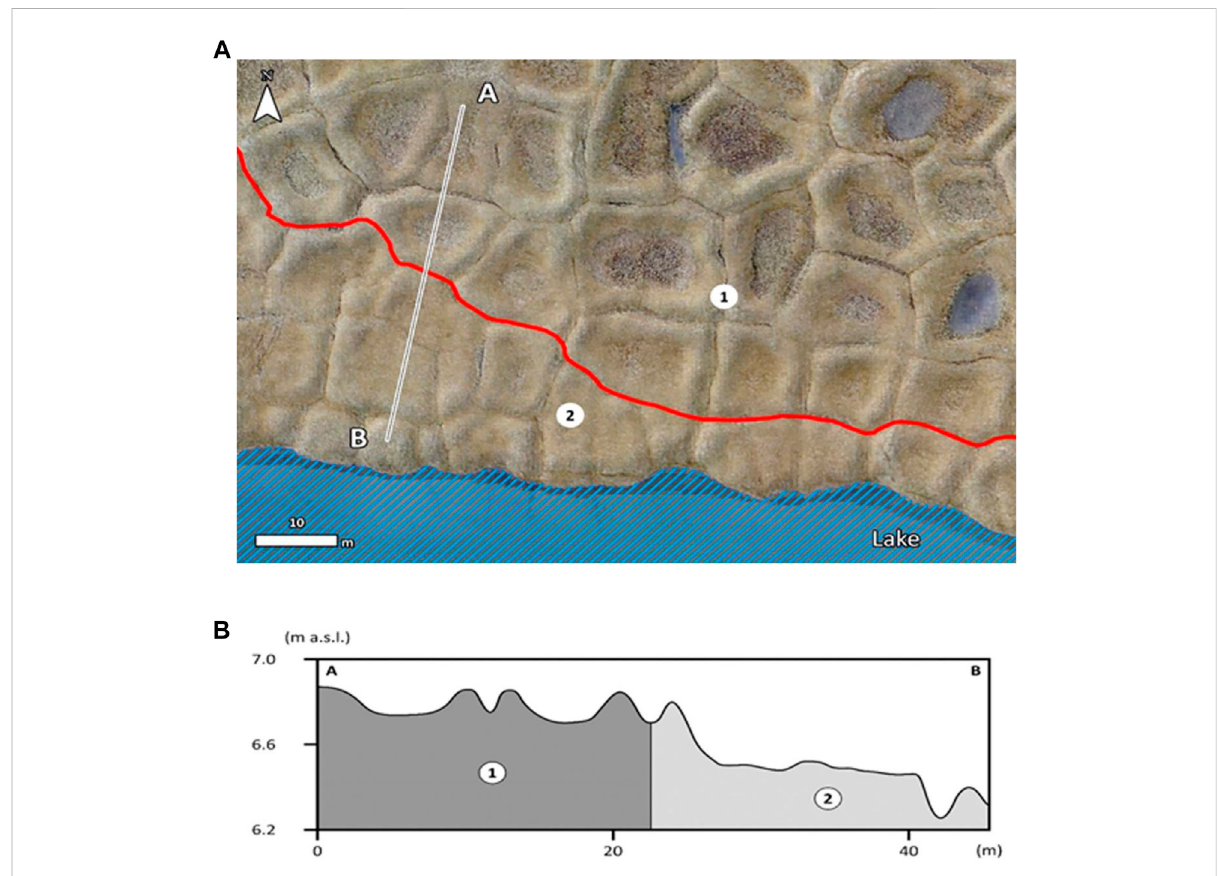
Figure 4 Wet (1) and dried (2) polygons on an orthophoto map that is mixed with a grey shaded relief (GSR) map (A) . The red line is a border between mapped polygon types. The topography pro fi le (B) was obtained by using ArcGIS and shows small hollows ’ presence in wet polygons ’ centers. In addition, it shows the surface general inclination in the case of dried polygons terrain. This inclination conditions water